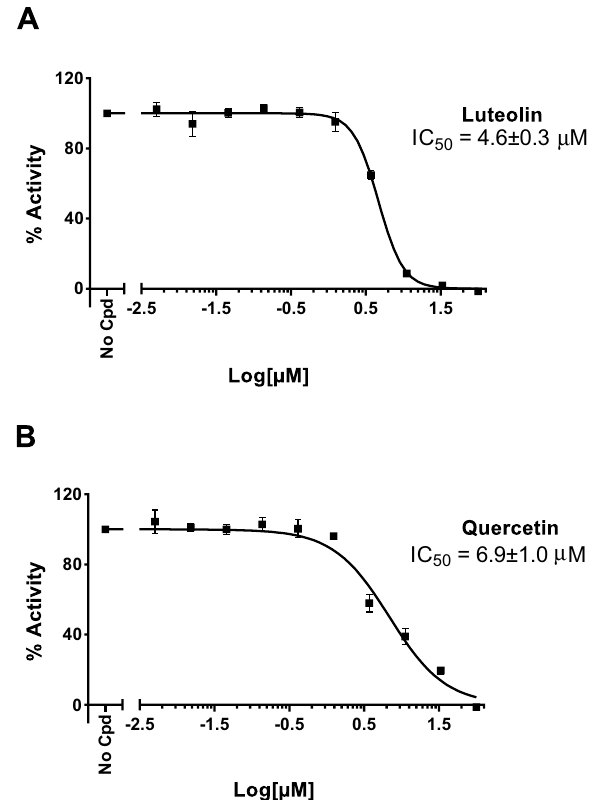
Figure 2. Dose–response curves to calculate IC 50 values for luteolin ( A ) and quercetin ( B ) by determining each compound’s inhibition activity at 10 different concentrations, ranging from 0.005 µM to 100 µM. The obtained IC 50 values for luteolin and quercetin are 4.6 ± 0.3 µM and 6.9 ± 1.0 µM, respectively.